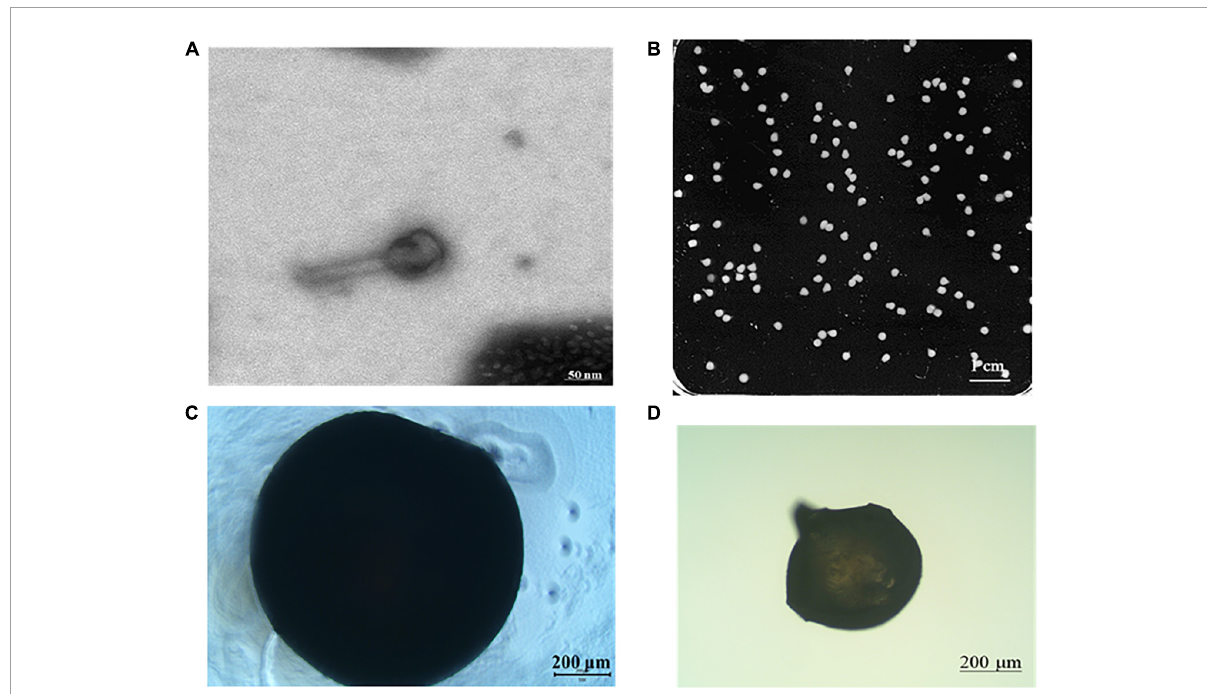
FIGURE3 Morphology of phage and phage microcapsule. (A) Phage morphology; (B) microcapsules photographed by digital camera; (C) microscopic view of wet microcapsules; (D) microscopic view of dry